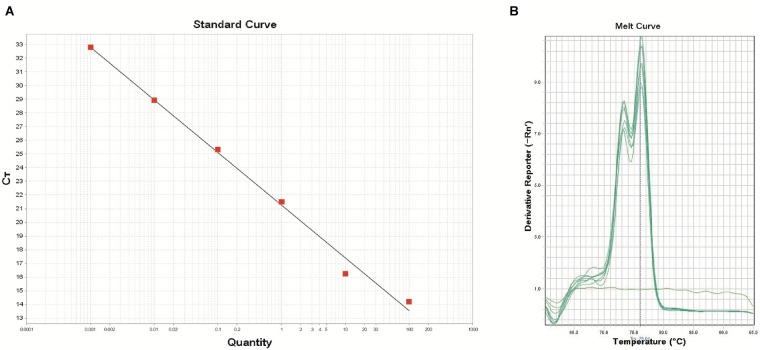
Standard curve (A) using the primer XRE (R2: 0.993, Eff%: 81.8) and melt curve peaks (B) for the detection of the transcriptional regulator and crystal protein genes in the B. thuringiensis strain. The DNA concentrations of B. thuringiensis ATCC 10792 were as follows: 1.0 × 102, 1.0 × 101, 1.0 × 100, 1.0 × 10-1, 1.0 × 10-2, and 1.0 × 10-3ng (from left to right). DNA amounts correspond to 2.6 × 106, 2.6 × 105, 2.6 × 104, 2.6 × 103, 2.6 × 102, and 2.6 × 101 CFU, respectively.